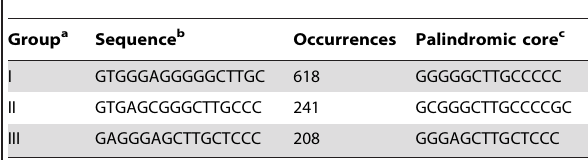
Table 1. Short repetitive sequence groups in the SBW25